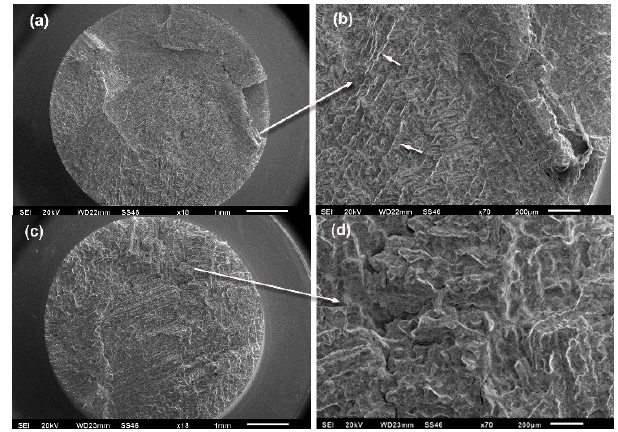
Figure 7. Surface fractures in alloys with 0.5 wt % B: ( a , b ) 0.5B-AC alloy after 4,196,143 cycles at 433 MPa; ( c , d ) 0.5B-HT alloy after 2,033,481 cycles at 615 MPa.